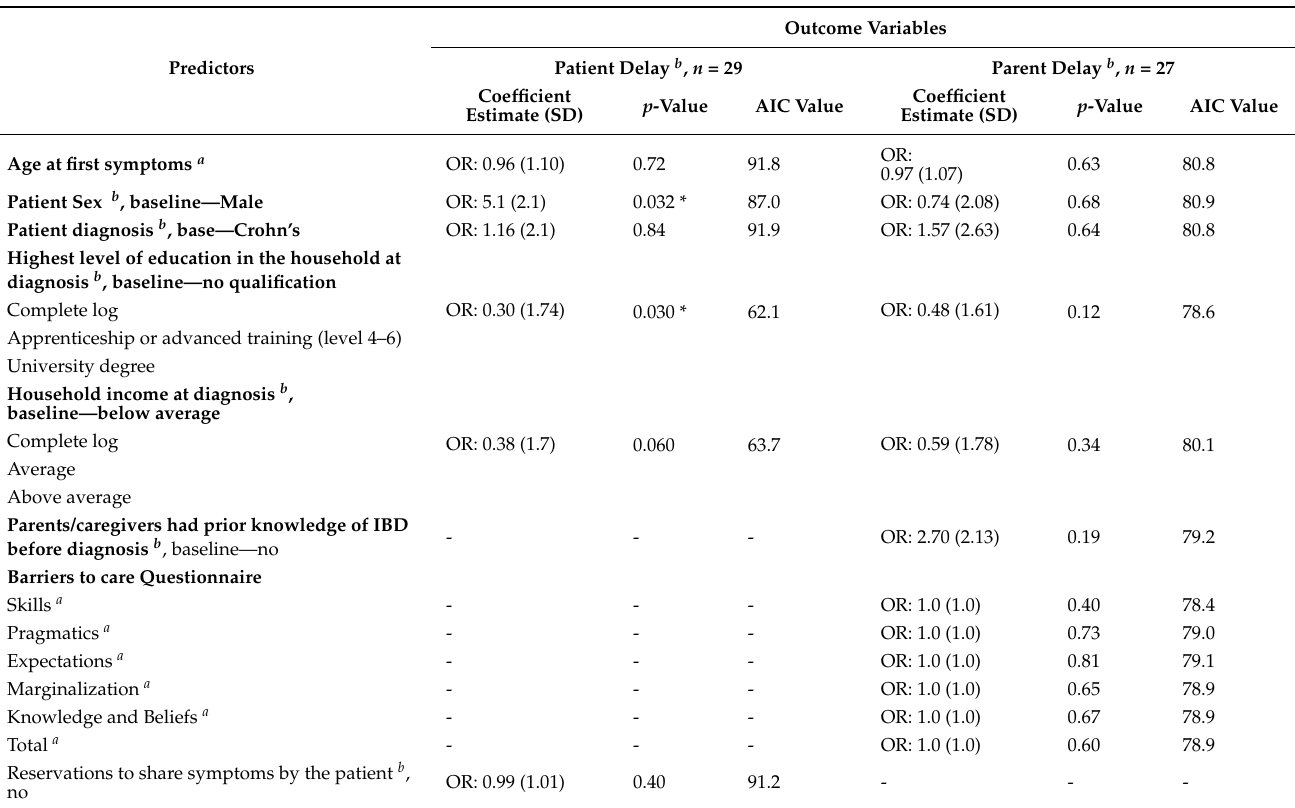
Table A2. Predictors for patient-associated and parent-associated delays. Logistic ordinal regression outcomes.